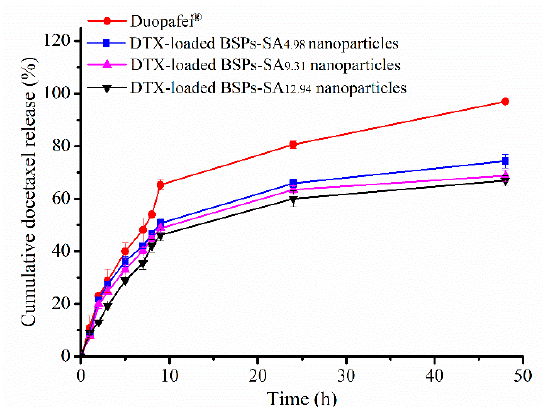
Figure 4. In vitro release profiles of docetaxel from Duopafei ® and DTX-loaded BSPs-SA nanoparticles with different DS values of stearic acid in pH 7.4 phosphate-buffered saline containing 0.2% of Tween 80 at 37 °C ± 0.5 °C. Results are expressed as mean ± SD. ( n = 3).